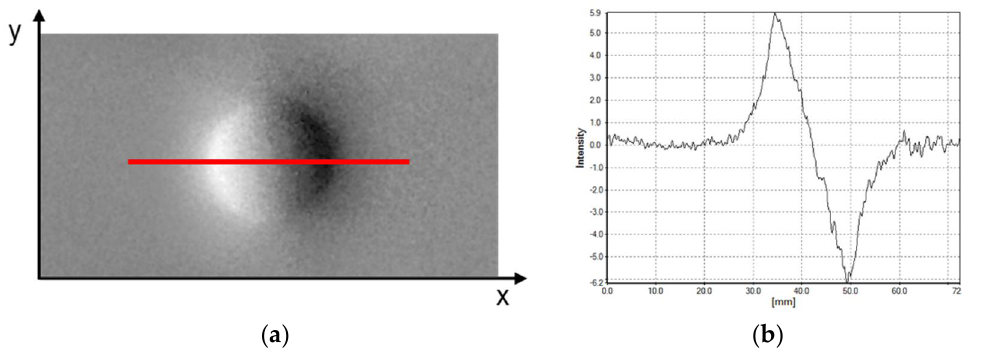
Figure 5. ( a ) Shearogram of the defect Ø 16 mm (HFB), RWT 0.75 mm, SNR ≈ 33; ( b ) course of the intensity values for the same defect along the red line.